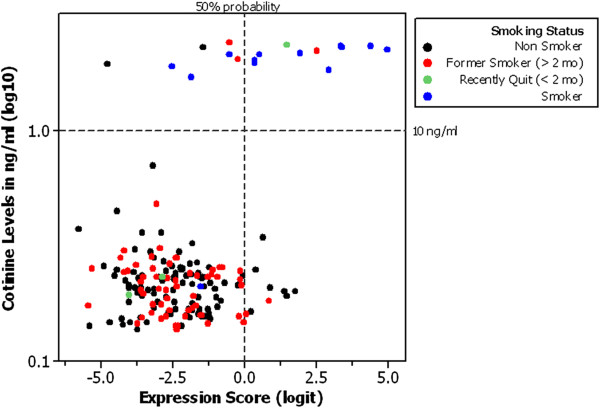
Comparison of gene expression score to cotinine levels in validation set. The y-axis shows the log10 value of cotinine levels in the 180 subject validation set; the horizontal dashed line (−−-) denotes the 10ng/ml threshold used in the AUC analysis. The x-axis shows the GES in the 180 subject validation set; the vertical dashed line denotes the 50% probability threshold used in the AUC analysis. Black circles = non-smokers; red circles = former smokers (> 2 months quit); green circles = recently quit smokers (< 2 months quit); blue circles = current smokers. All smoking categories are self-reported.